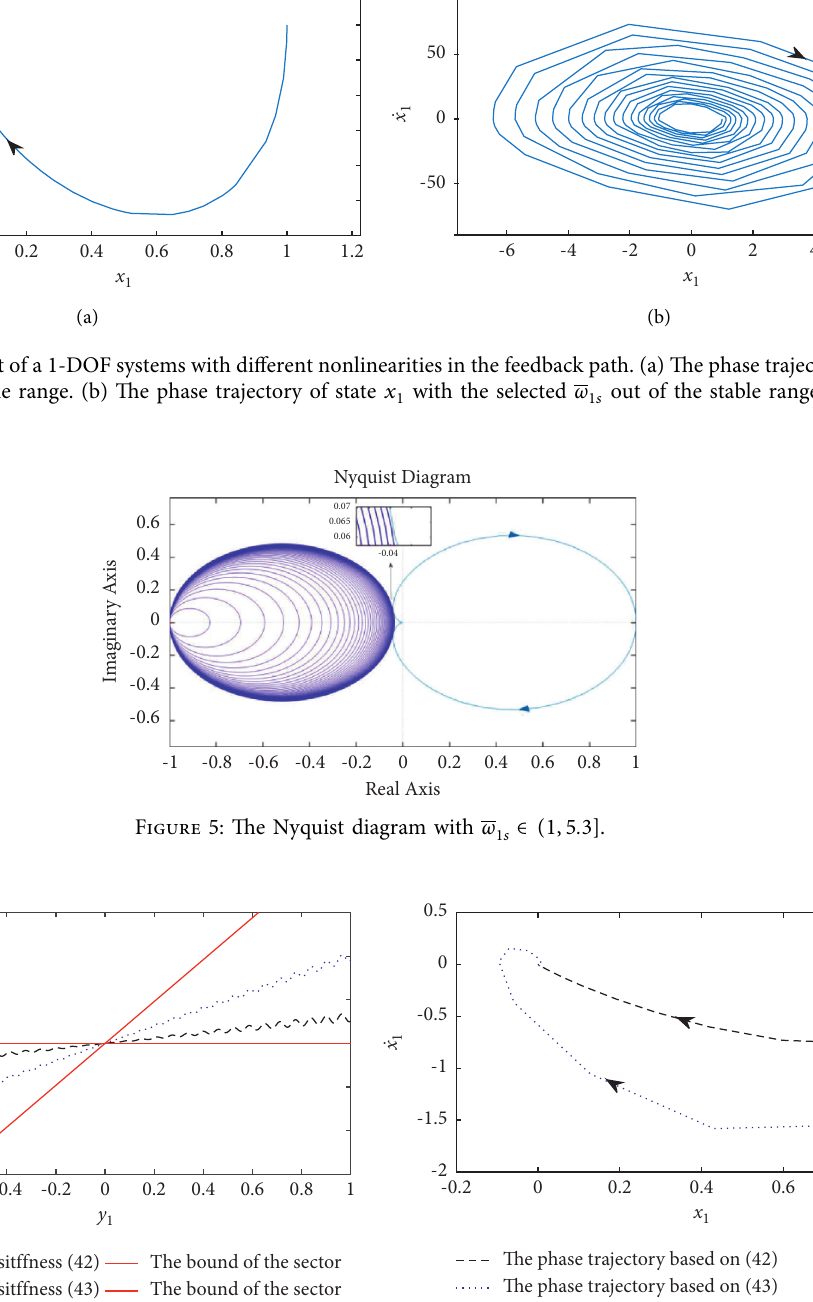
Figure 6: A comparison between the method proposed in this paper and the traditional quadratic Lyapunov function method. (a) The sector region induced by a VSS. (b) The phase portrait of a 1-DOF system with a